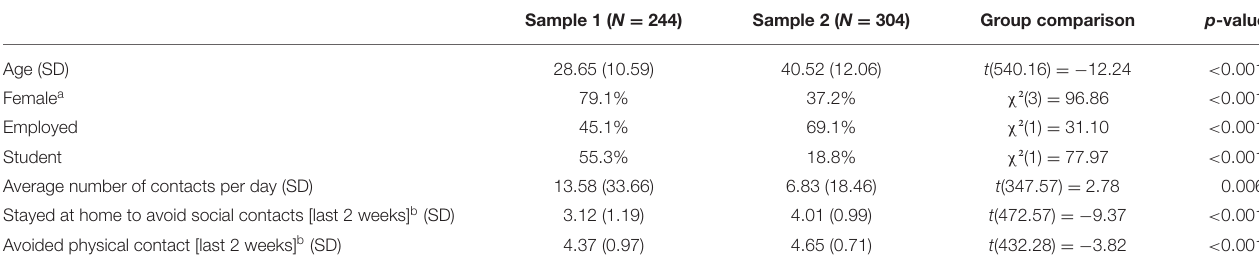
TABLE 1 | Characteristics of study